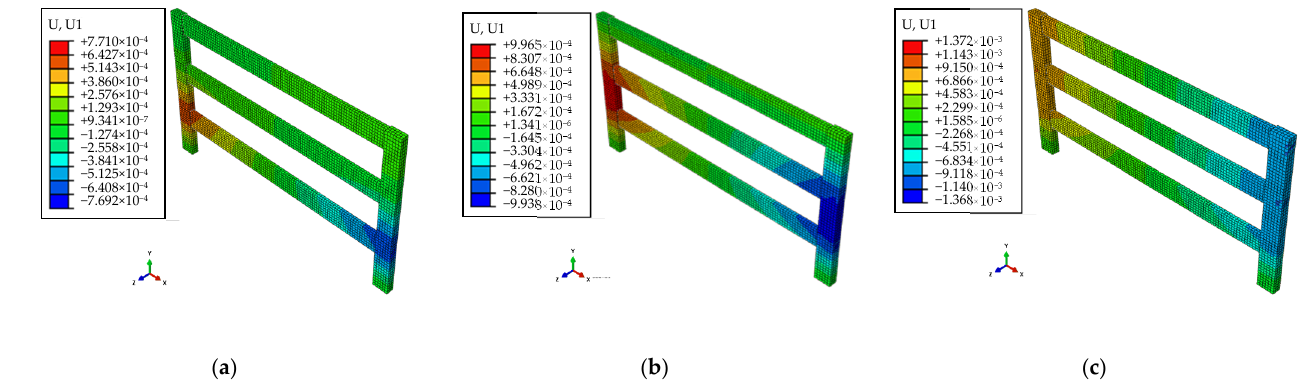
Figure 11. The X-direction displacement of the several-layer stretching plan. ( a ) Stretching of first layer prestressed tendons. ( b ) Stretching of second layer prestressed tendons. ( c ) Stretching of third layer prestressed tendons.